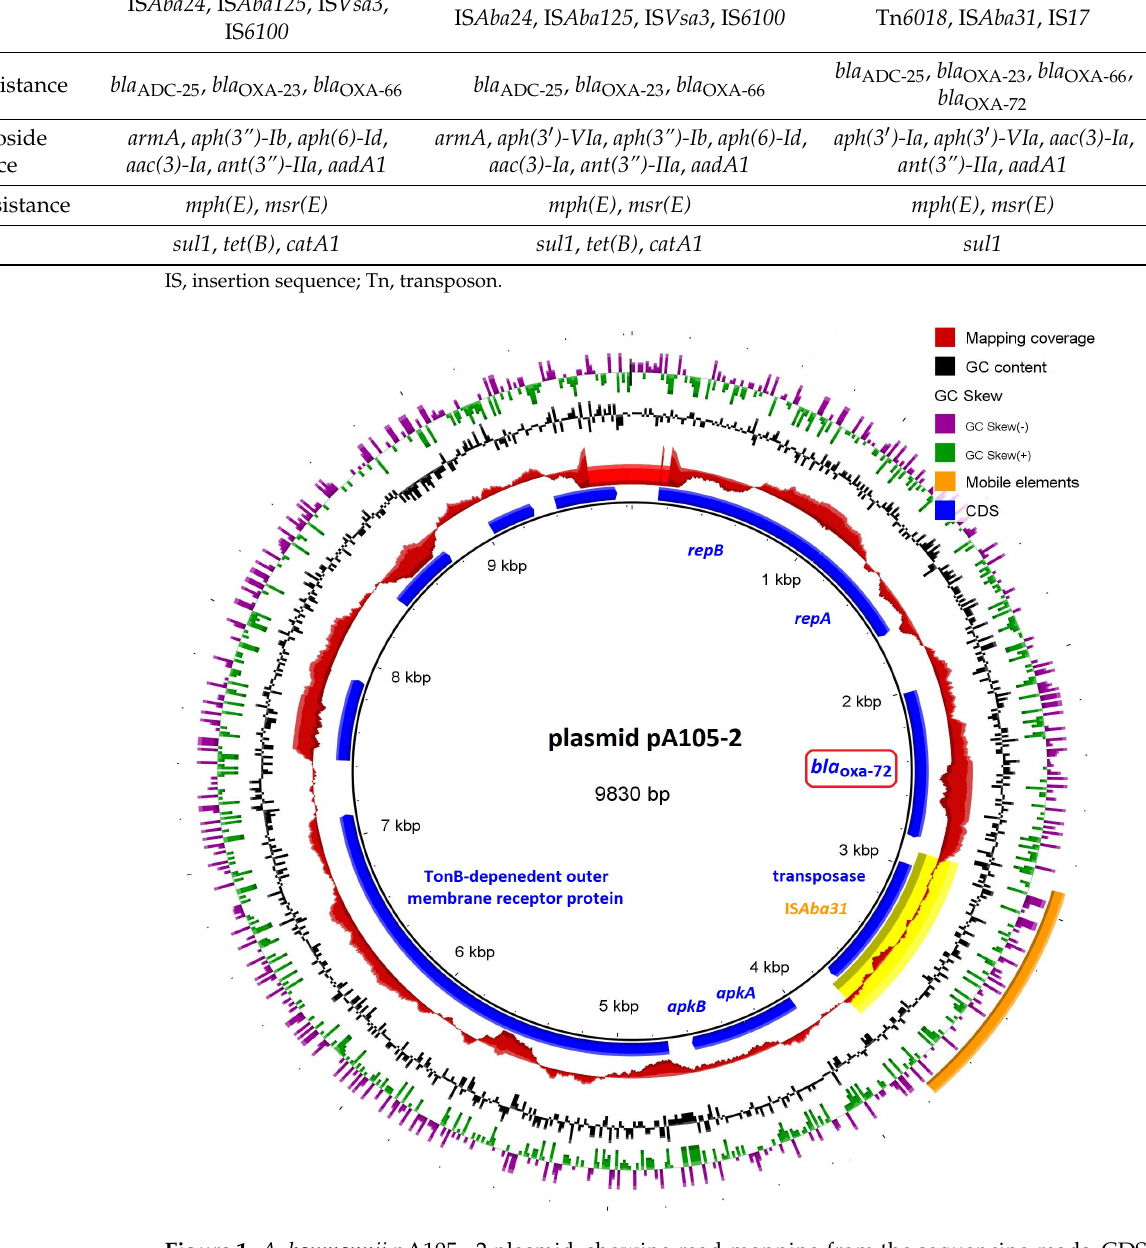
Figure 1. A. baumannii pA105 − 2 plasmid, showing read-mapping from the sequencing reads, CDS and mobile genetic elements. Alignments were performed using BLAST+. The image was generated using BRIG. CDS; coding sequences.